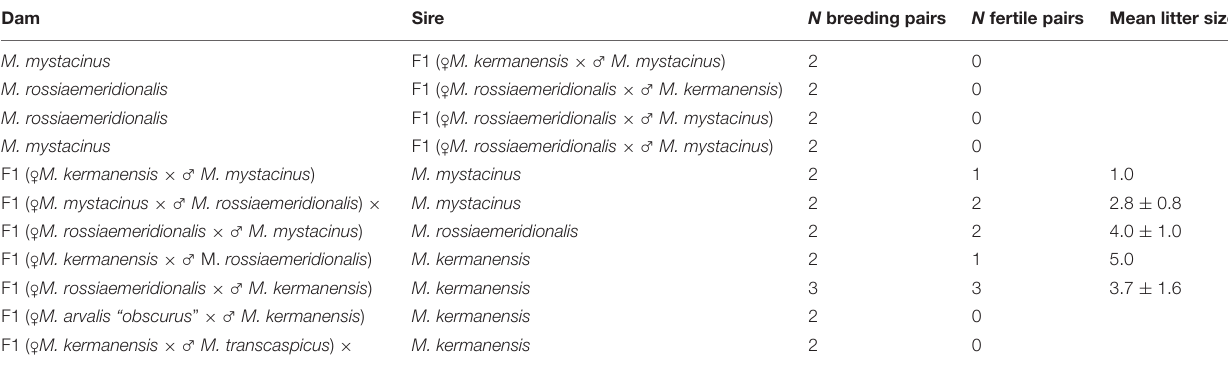
TABLE 3 | Reproductive performance of F1 interspecies hybrids of the subgenus Microtus in backcrosses to the parental species. Dam Sire N breeding pairs N fertile pairs Mean litter